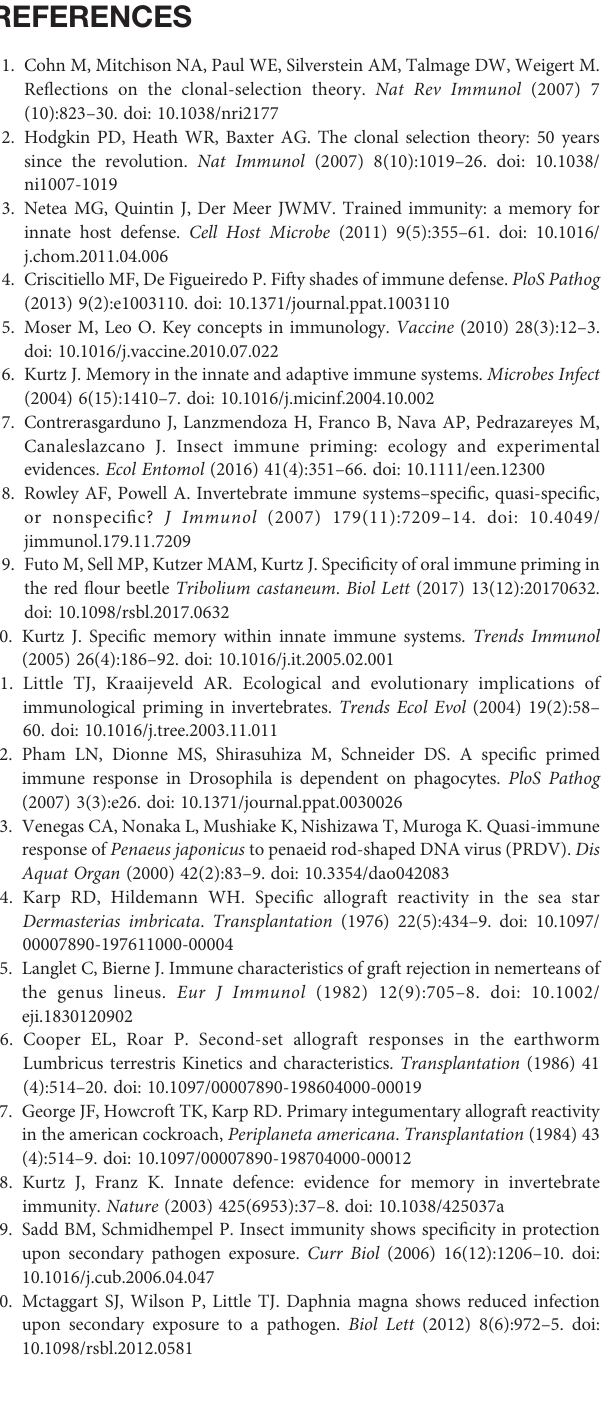
SUPPLEMENTARY FIGURE 3 | Expression of AMP genes in hemocytes after the IPP and ICP. The x -axis denotes hours after bacterial injection [IPP (6, 9, and 72 h) and the ICP (174, 177, and 240 h)]. The y -axis re fl ects expression of genes of members of the TLR signaling pathway. The signi fi cant difference between the